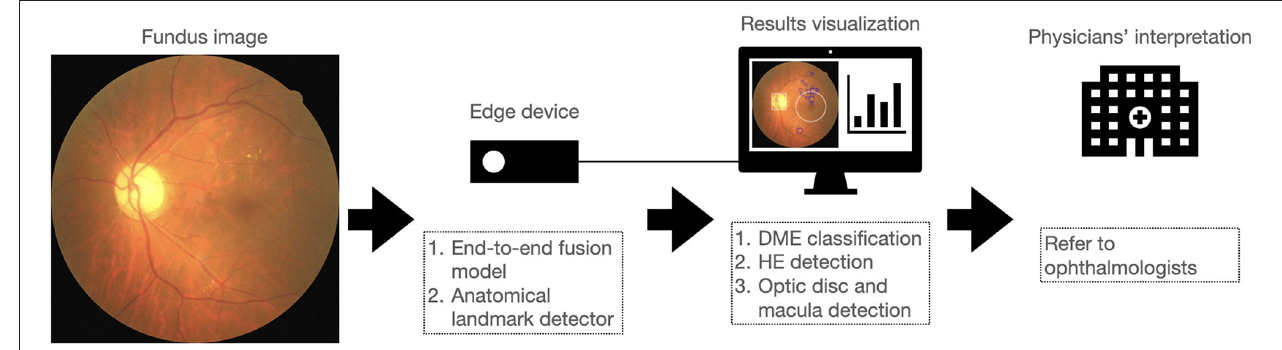
FIGURE 9 | Overview of the proposed approach for implementing a system on an edge device that integrates DME classification, HE detection, and optic disc and macula detection to assist in the interpretation of fundus image by physicians.